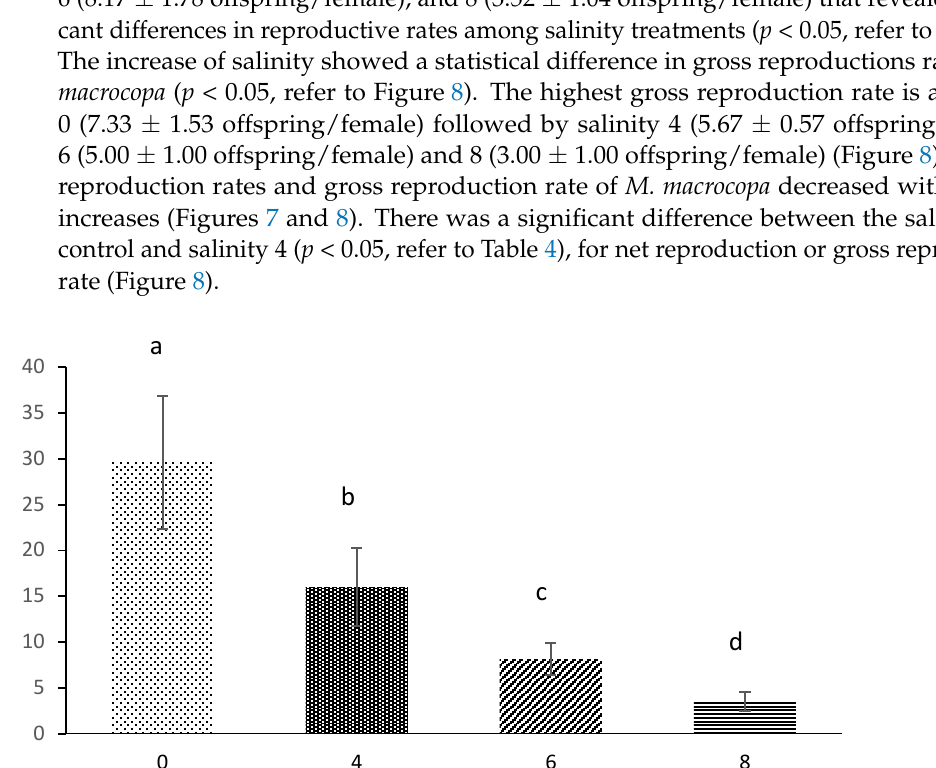
Figure 7. The net reproduction rate of M. macrocopa for different salinity treatments. The different small letters indicate significant difference between different salinity treatments ( p < 0.05).